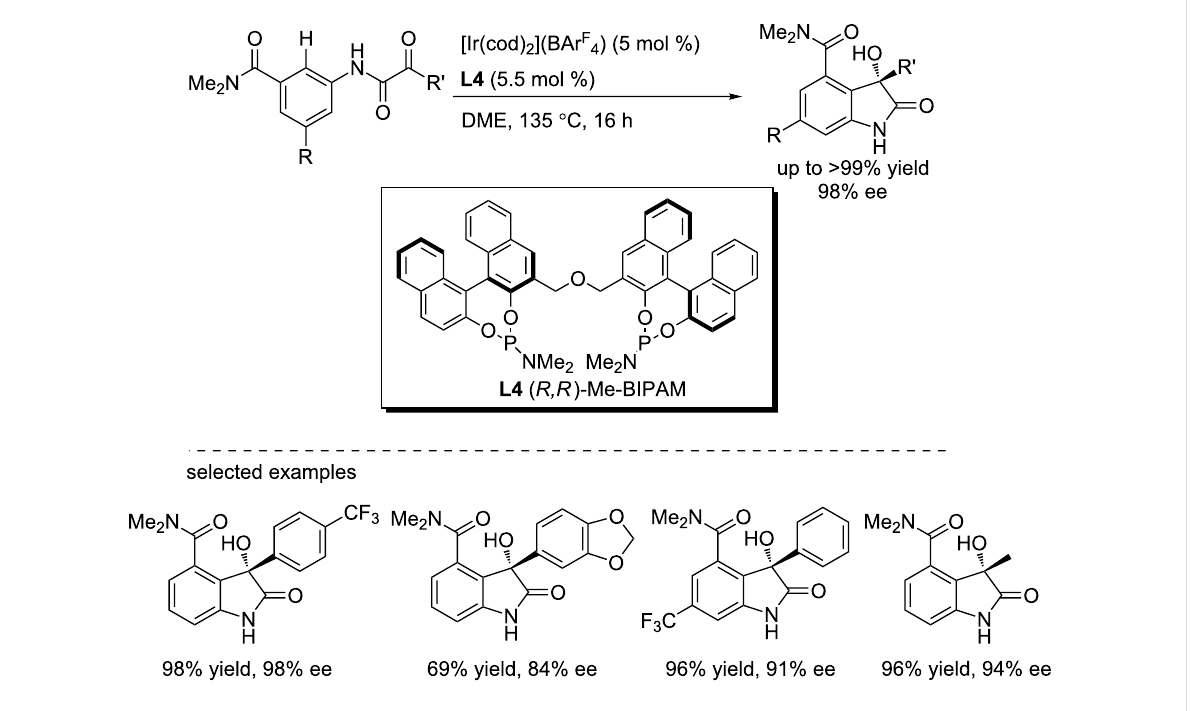
Scheme 7: Asymmetric intramolecular direct hydroarylation of α